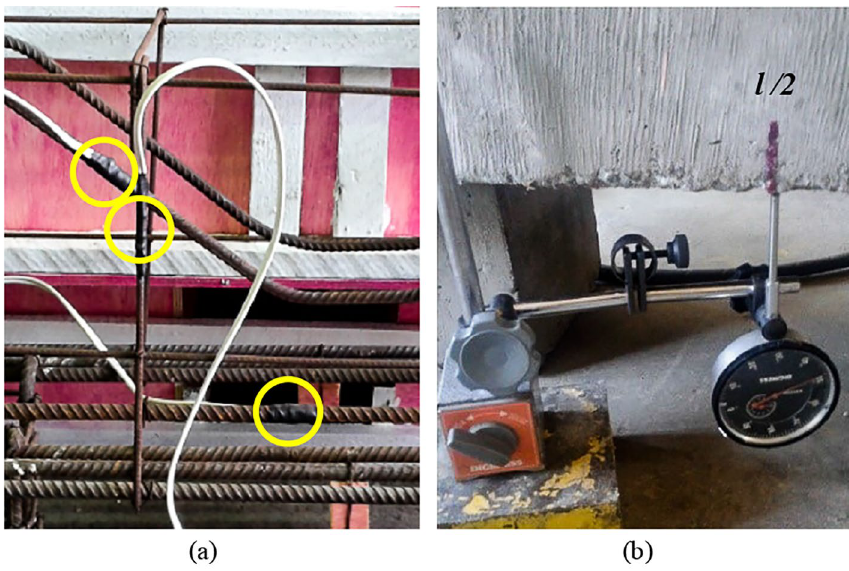
Figure 6. Instrumentation: ( a ) installed strain gauges and ( b ) deflectometer placement.